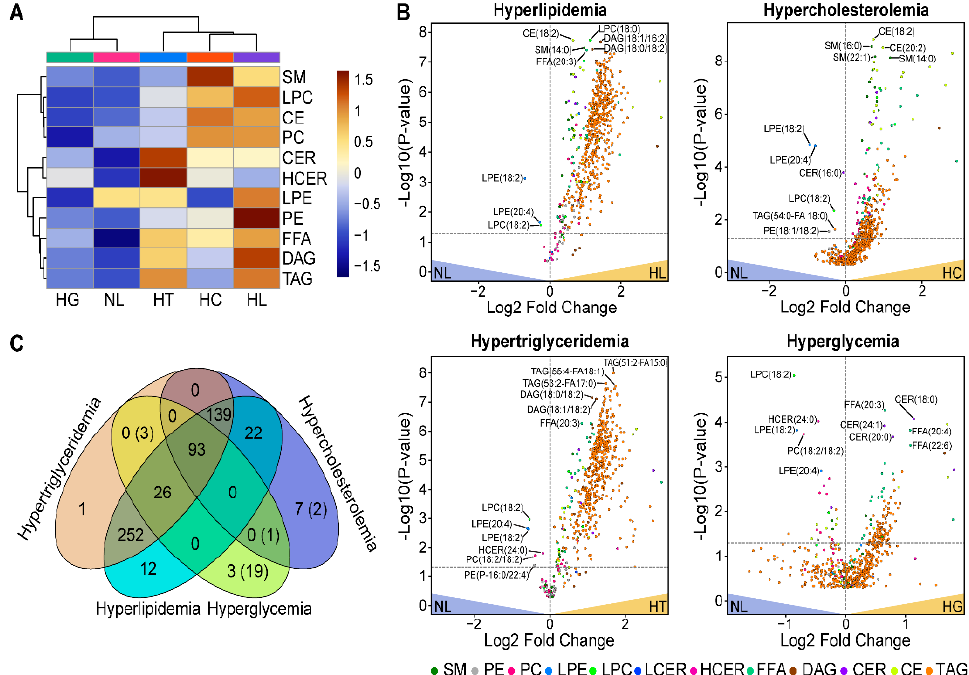
Figure 1. Dysregulated lipid classes and individual lipid species in metabolic groups. ( A ) Heat map comparison and clustering of lipid class concentrations for hyperlipidemia (HL), hypercholesterolemia (HC), hypertriglyceridemia (HT), hyperglycemia (HG), and normolipidemic (NL) samples. The lipid classes and sample groups are shown in rows and columns, respectively. The colors correspond to the Z-score normalized by the grand mean of each lipid class concentration. ( B ) Volcano plots show individual lipid species concentrations that were dysregulated relative to normal (NL) samples. The horizontal line on the plots shows a p -value ≤ 0.05. ( C ) The Venn diagram summarizes the number of lipid species significantly upregulated in different metabolic groups, the numbers in parentheses show the number for downregulated lipids.